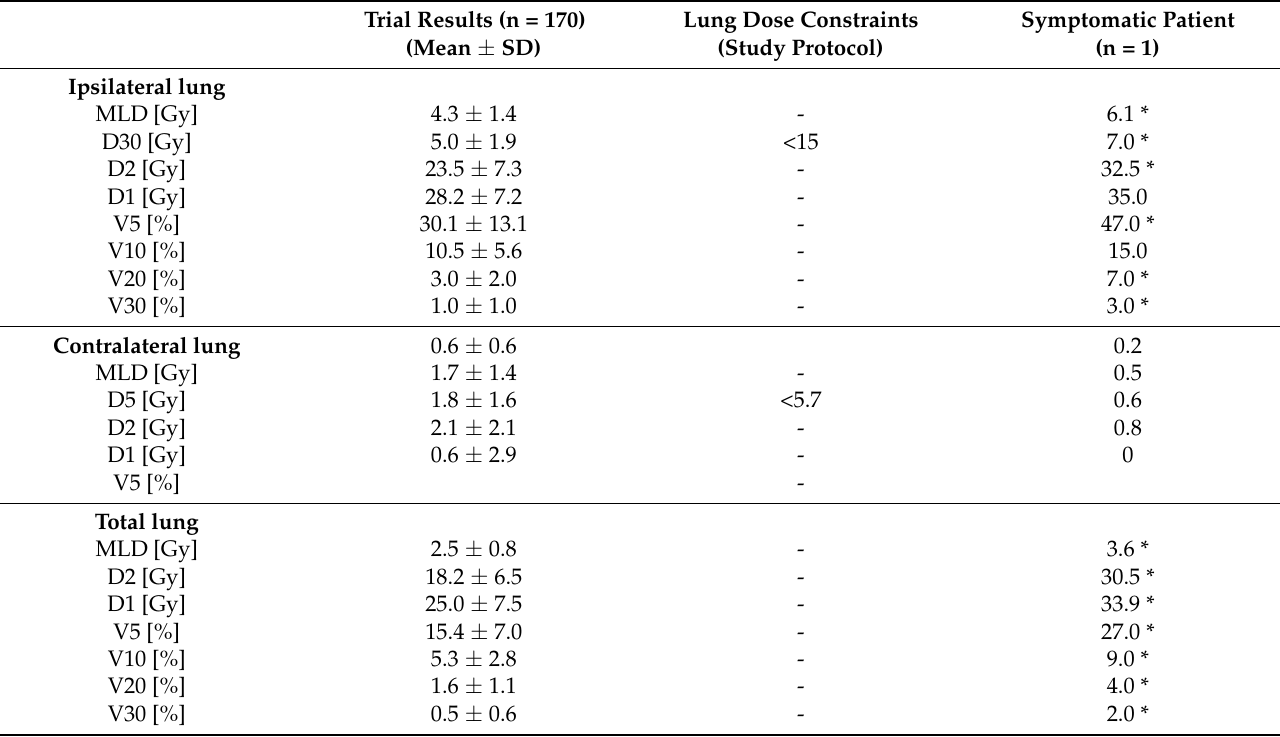
Table 1. Lung dose analysis of all patients in comparison to the patient with symptomatic pneumonitis. Trial Results (n =